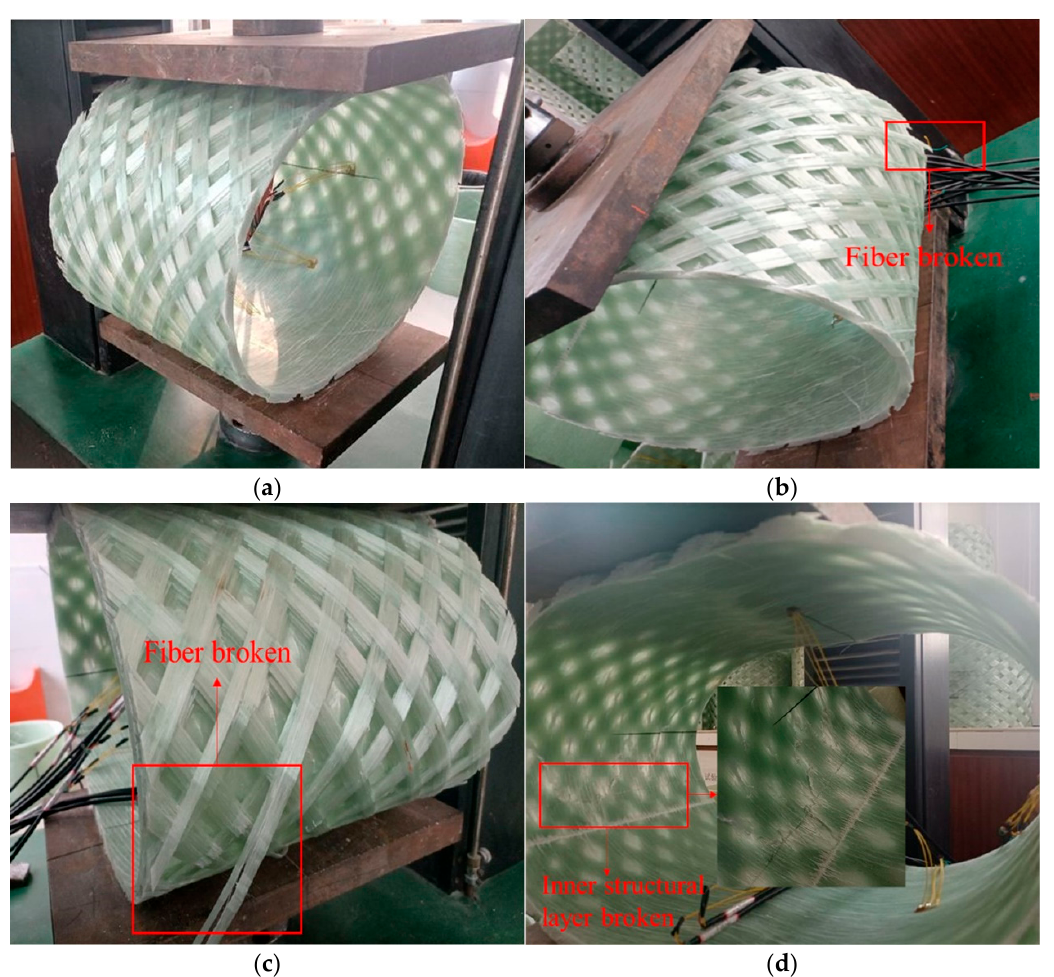
Figure 14. Deformation of outer stiffened pipes during failure phase: ( a ) 3% diametric deflection; ( b ) 15% diametric deflection; ( c ) 20% diametric deflection; ( d ) 30% diametric deflection.